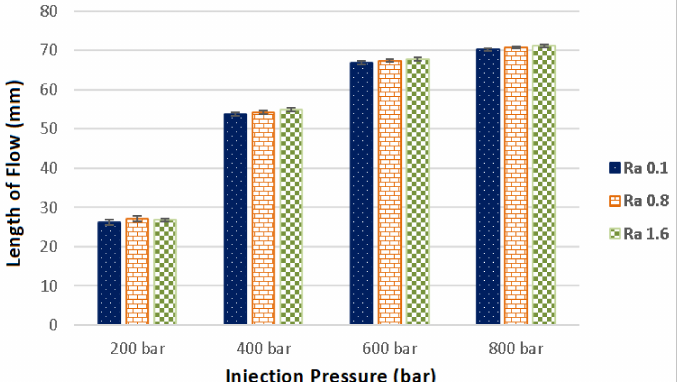
Figure 4. Dependence of flow length on the injection pressure for each surface roughness (Ra 0.1, Ra 0.8, Ra